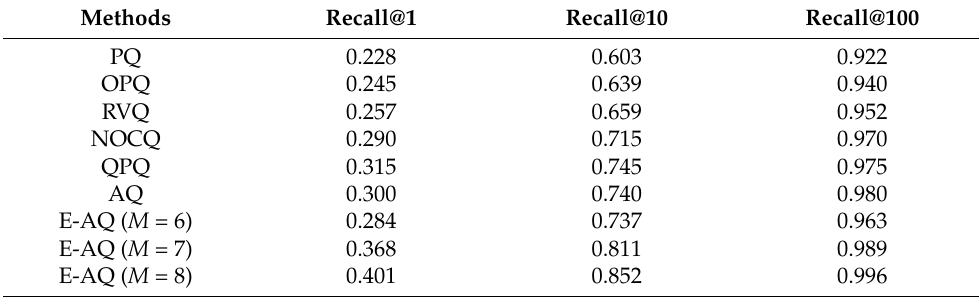
Table 2. Comparison of exhaustive ANN searches on SIFT-1M.